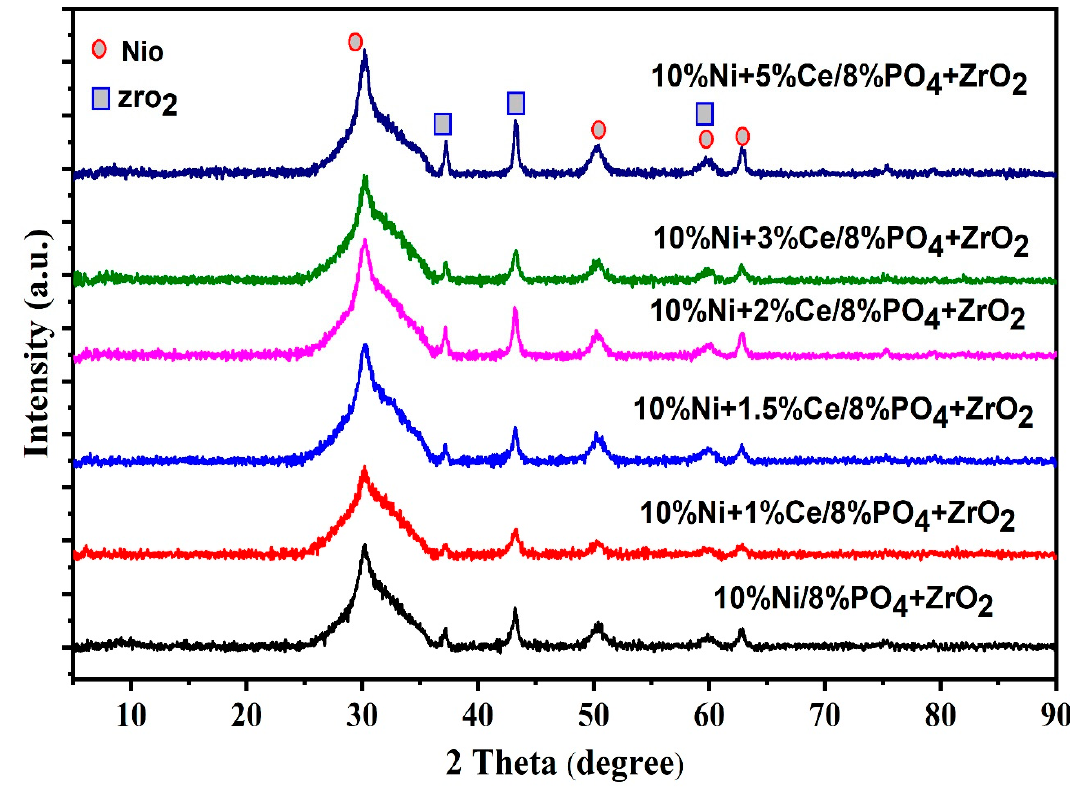
Figure 2. X-ray diffraction patterns of 10Ni + x%Ce/8%PO 4 + ZrO 2 catalysts (x = 0, 1, 1.5, 2, 3, 5) calcined ◦ at 600 °C. calcined at 600